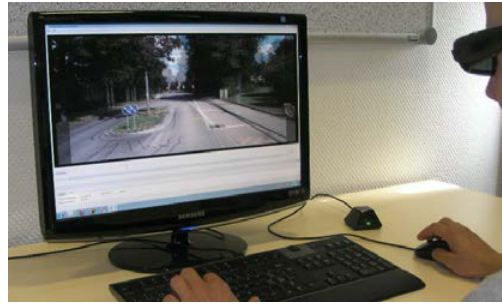
Figure 4. Stereoscopic workstation